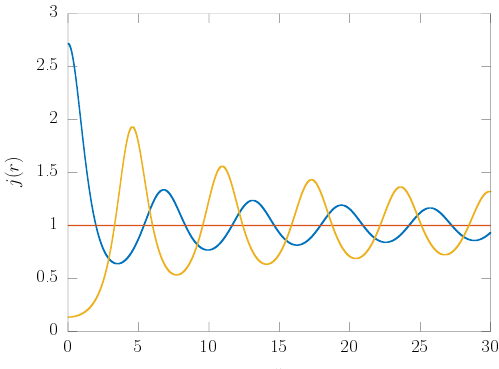
Figure 2. Solutions of Equation (12) with the minus sign. The fixed point j = 1 is an attractor and some current oscillations are observed. Initial conditions are φ ( 0 ) = 1 (blue), φ ( 0 ) = 0 (orange) and φ ( 0 ) = 2 (yellow). −